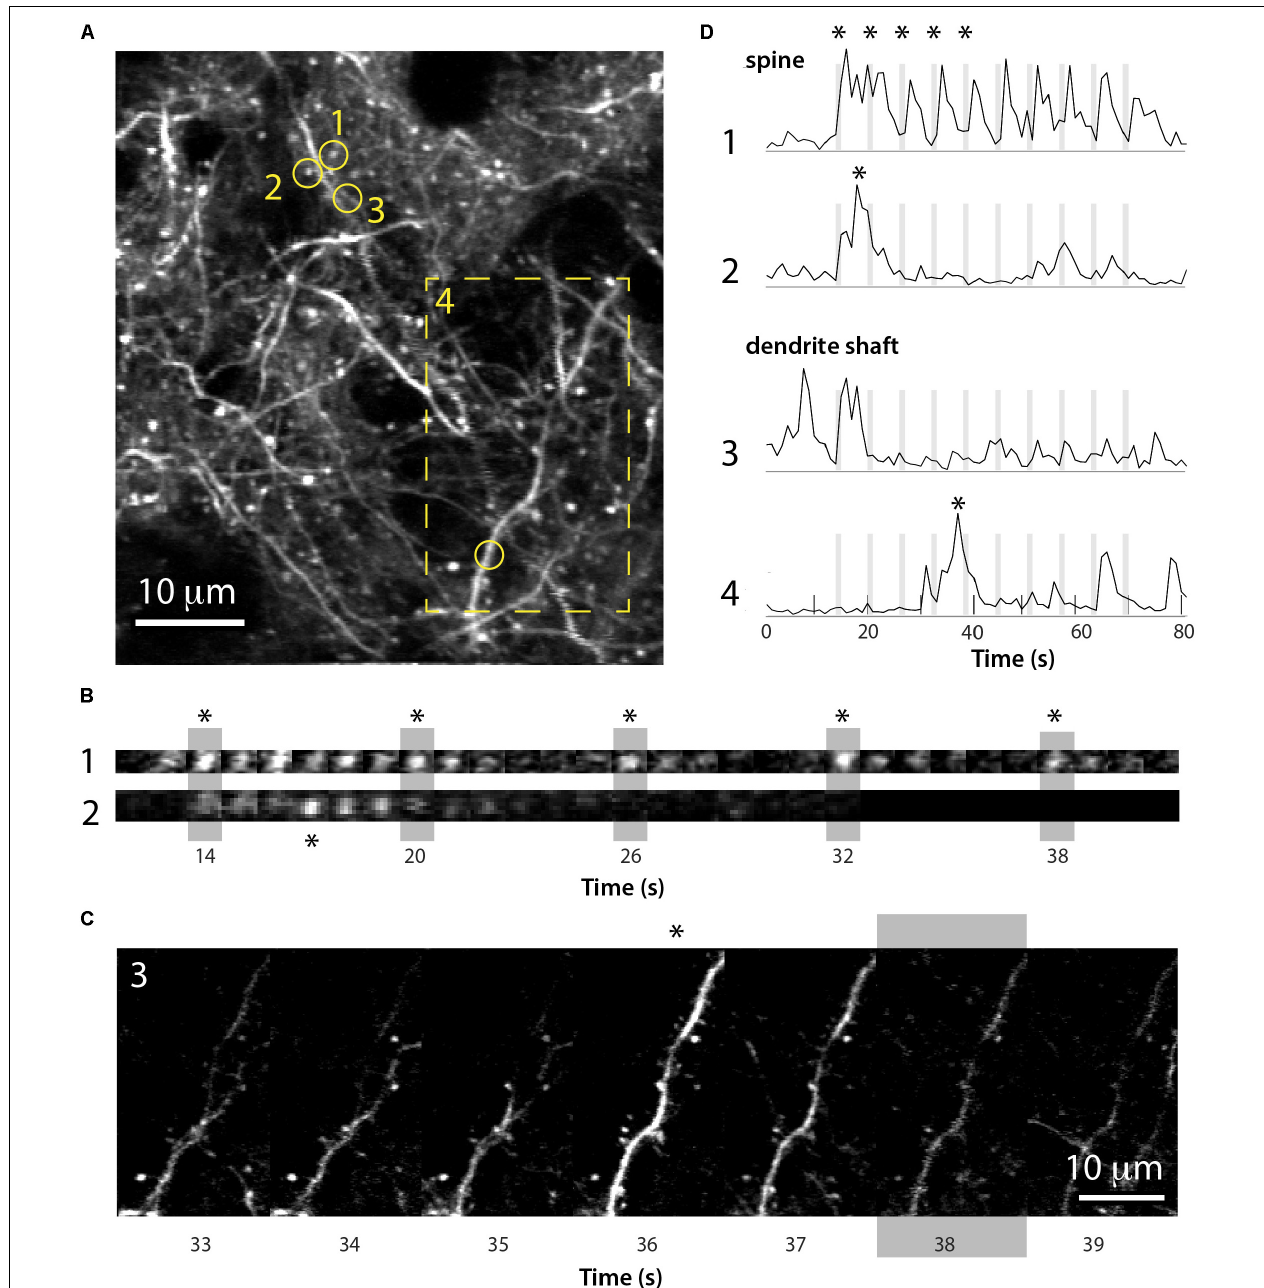
FIGURE 8 | Imaging of GCaMP6s signals in dendritic spines of L2/3 neurons in barrel cortex at P15. (A) Field of view of apical dendrites from a representative experiment in a P15 mouse injected at P1 with rAAV-GCaMP6s ( xyt st-dev projection of 80 slices over ∼ 80 s). Time-lapse images of calcium recording of spines 1 and 2 (circles) and dendrite 4 (boxed region) are shown in (B,C) . (B) Time lapse imaging sequence of dendritic spines 1 and 2 shown in (A) over five consecutive whisker stimulations (vertical gray bars). Each image is one frame (0.98 Hz image acquisition). Asterisks for each spine in (B) correspond to those in panel (D) . (C) Time lapse imaging sequence of the dendrite shown in (A) (box 4) over several seconds and a whisker stimulation (gray bar). Each image is one frame (0.98 Hz image acquisition). The asterisk above the time frame at 36 s corresponds to the asterisk in panel (D) . (D) (cid:49) F / F traces for the calcium fluorescence signals for the dendritic spine and dendrite shaft regions of interest 1–4 shown in (A) , over 10 sequential whisker stimulations.